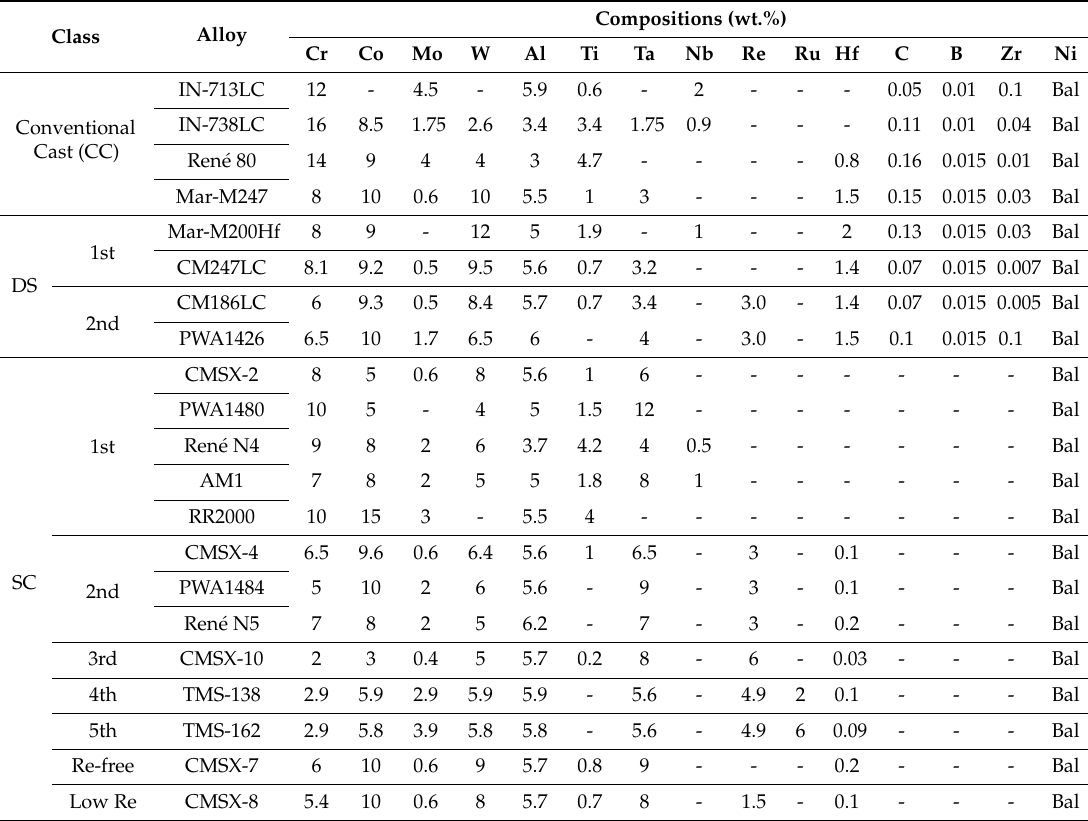
Table 1. Composition of cast